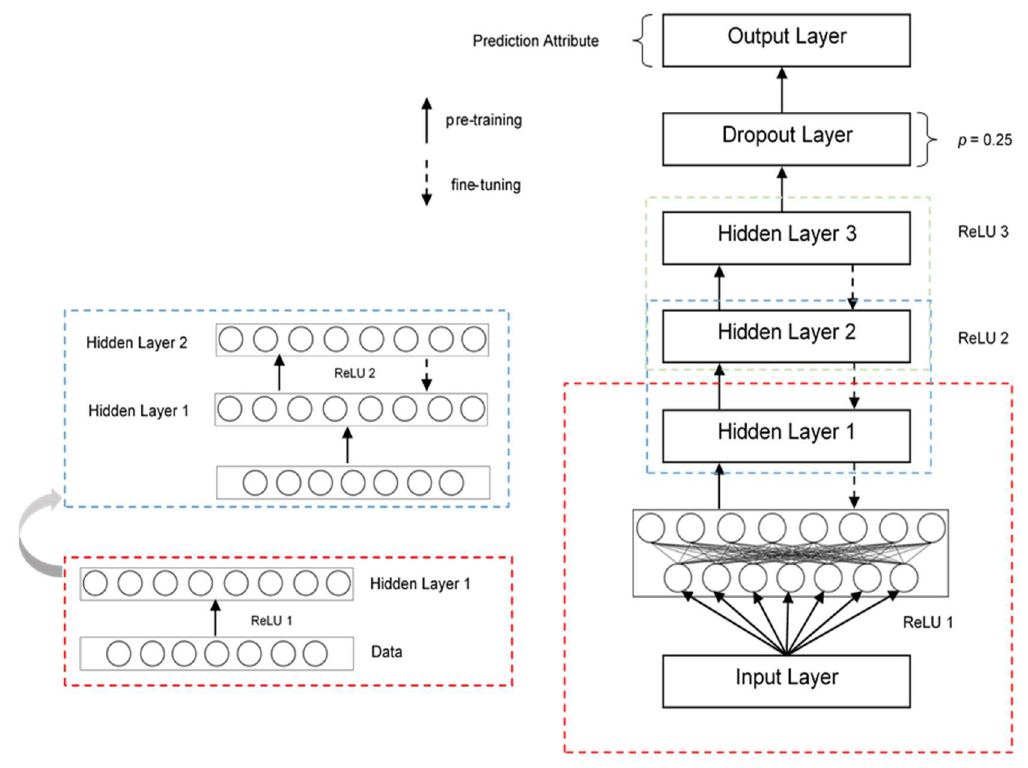
Figure 6. The proposed deep neural network model.